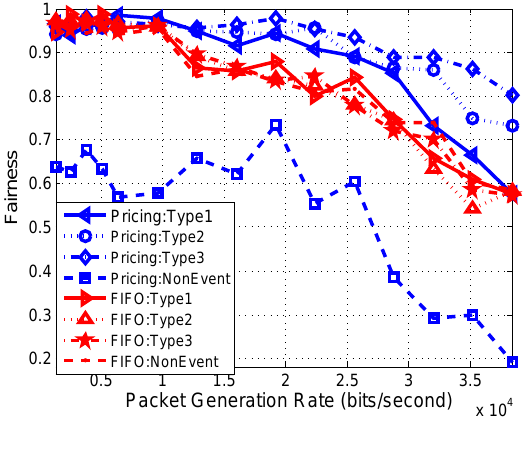
Figure 18. Fairness of different classes of Event packets for random topology.